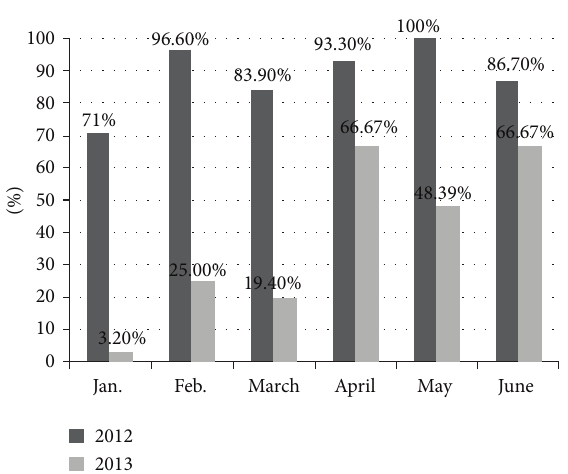
Figure 2: Comparison of the attainment rates of the citywide air quality during the first 6 months of 2012 and